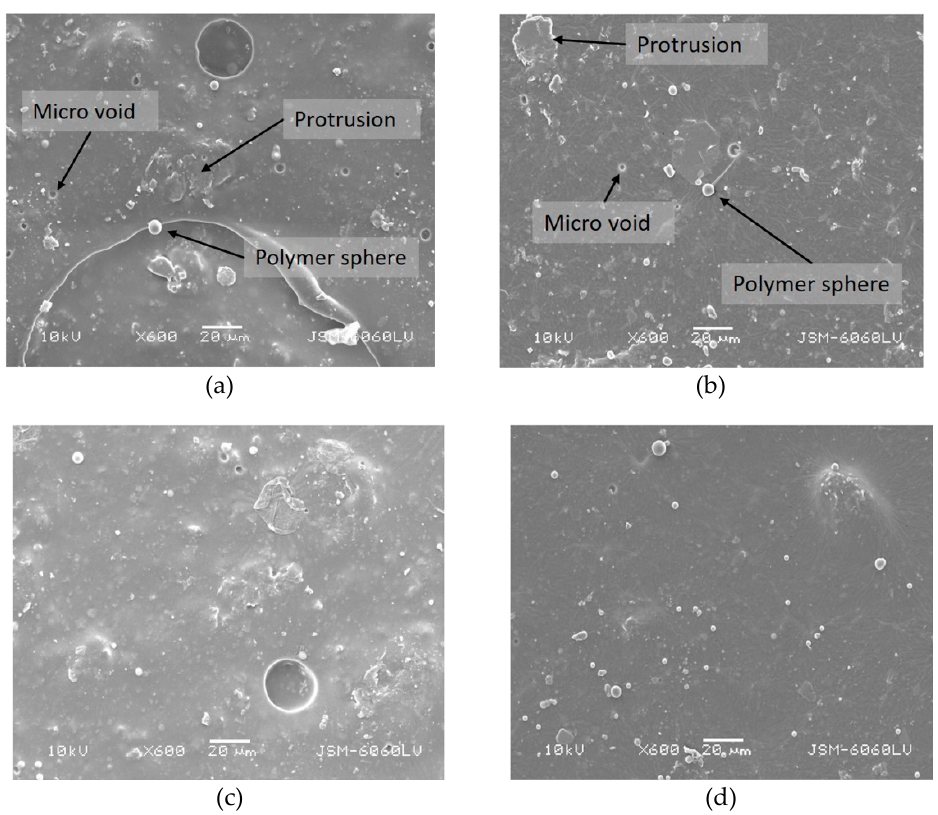
Figure 13. Surface morphology of samples ( a ) FC + 1% SiO 2 —unaged, ( b ) FC + 0.5% TiO 2 —unaged,